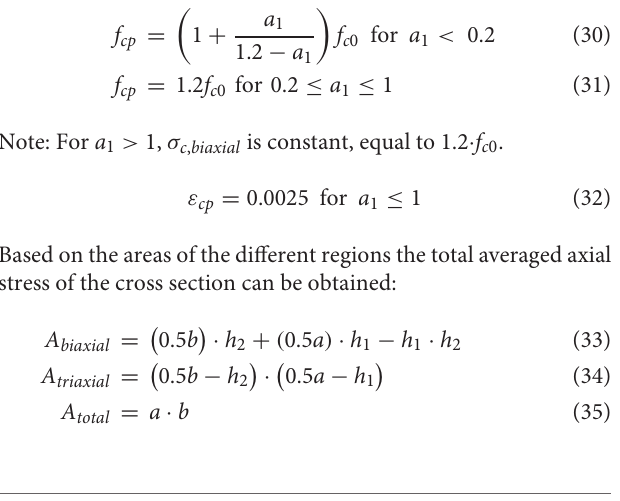
TABLE 1 | Proposed values for the parameters of the failure criterion by Ottosen (1977).